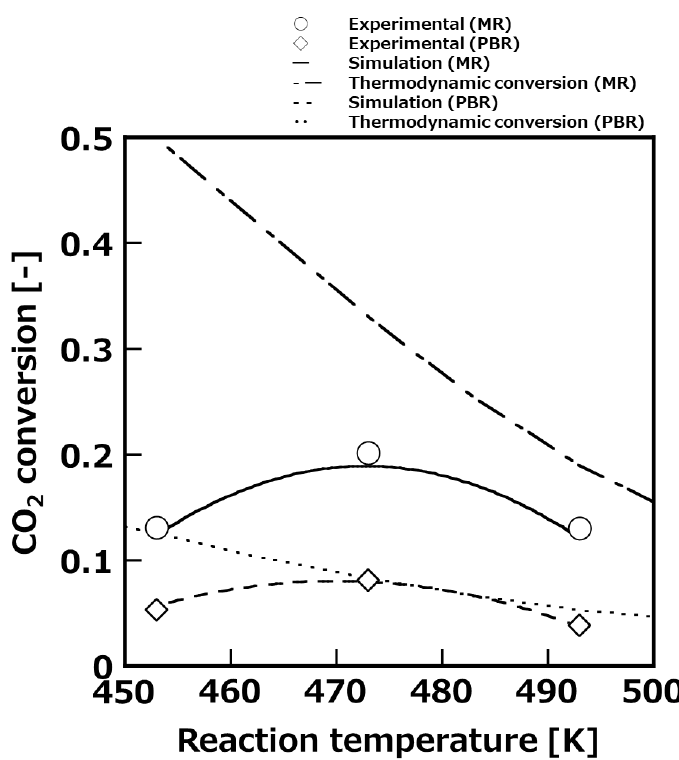
Figure 4. Temperature dependence of CO 2 conversion to compare with membrane reactor (MR) and packed-bed reactor (PBR) at 1 MPa.